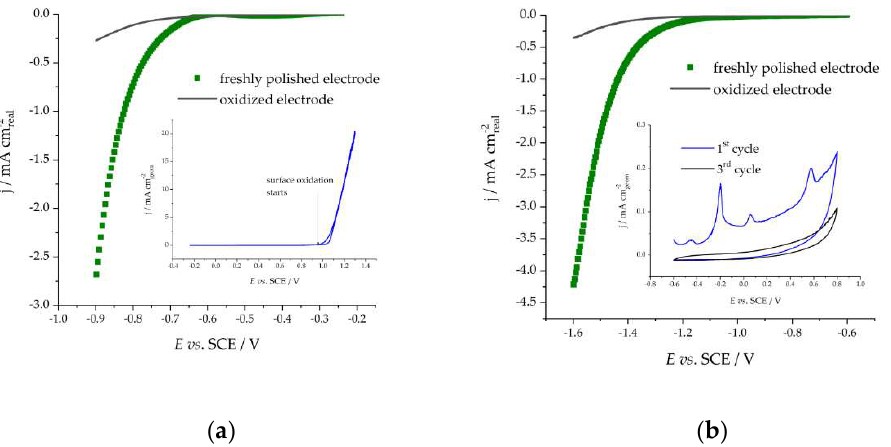
Figure 4. The HER polarization curve of the Cr electrode before and after oxidative treatment in ( a ) 0.1 mol dm − 3 HClO 4 and ( b ) 0.5 mol dm − 3 NaCl; insets show cycling voltammograms of the Cr electrode during which an irreversible oxide layer formation takes place. Roughly 10 times higher current at anodic vertex potential is observed in the HClO 4 solution compared to the NaCl solution.